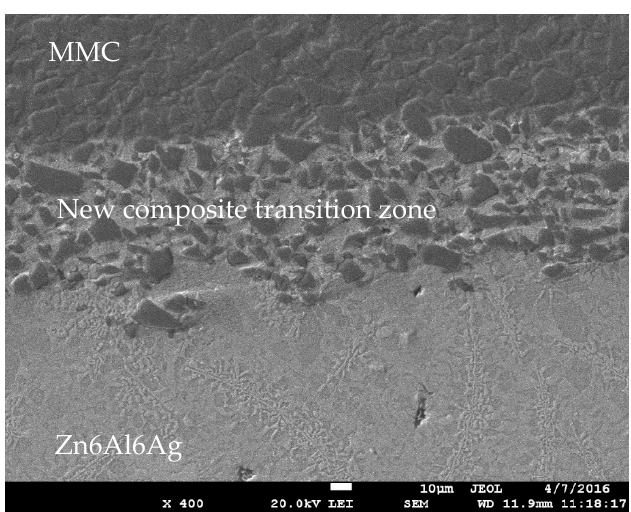
Figure 9. Microstructure of boundary in the metal–ceramic composite (MMC)/Zn6Al6Ag joint.